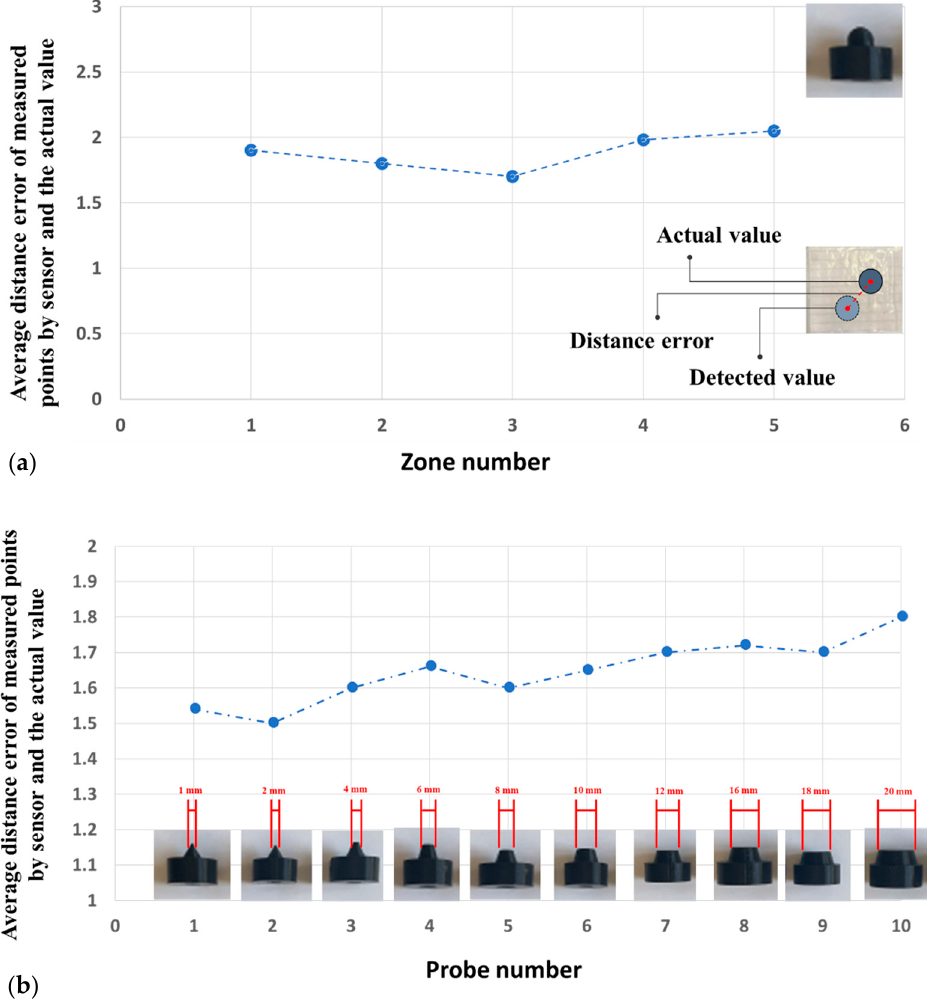
Figure 7. The average distance error of measured point by the sensor and actual value: ( a ) Each probe is touching Zone 1 to Zone 5, repeating 10 times to record the sensor measuring point, and ( b ) different probes are utilized to touch the center of the sensor 10 times.